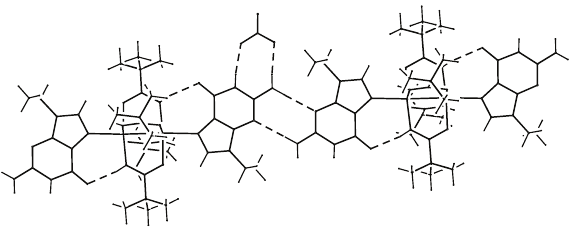
Figure 2: View of the H-bonds along the chains of [Pt 2 { HN = C(Bu t )O } 4 (9-EtG) 2 ] 2+ complexes.